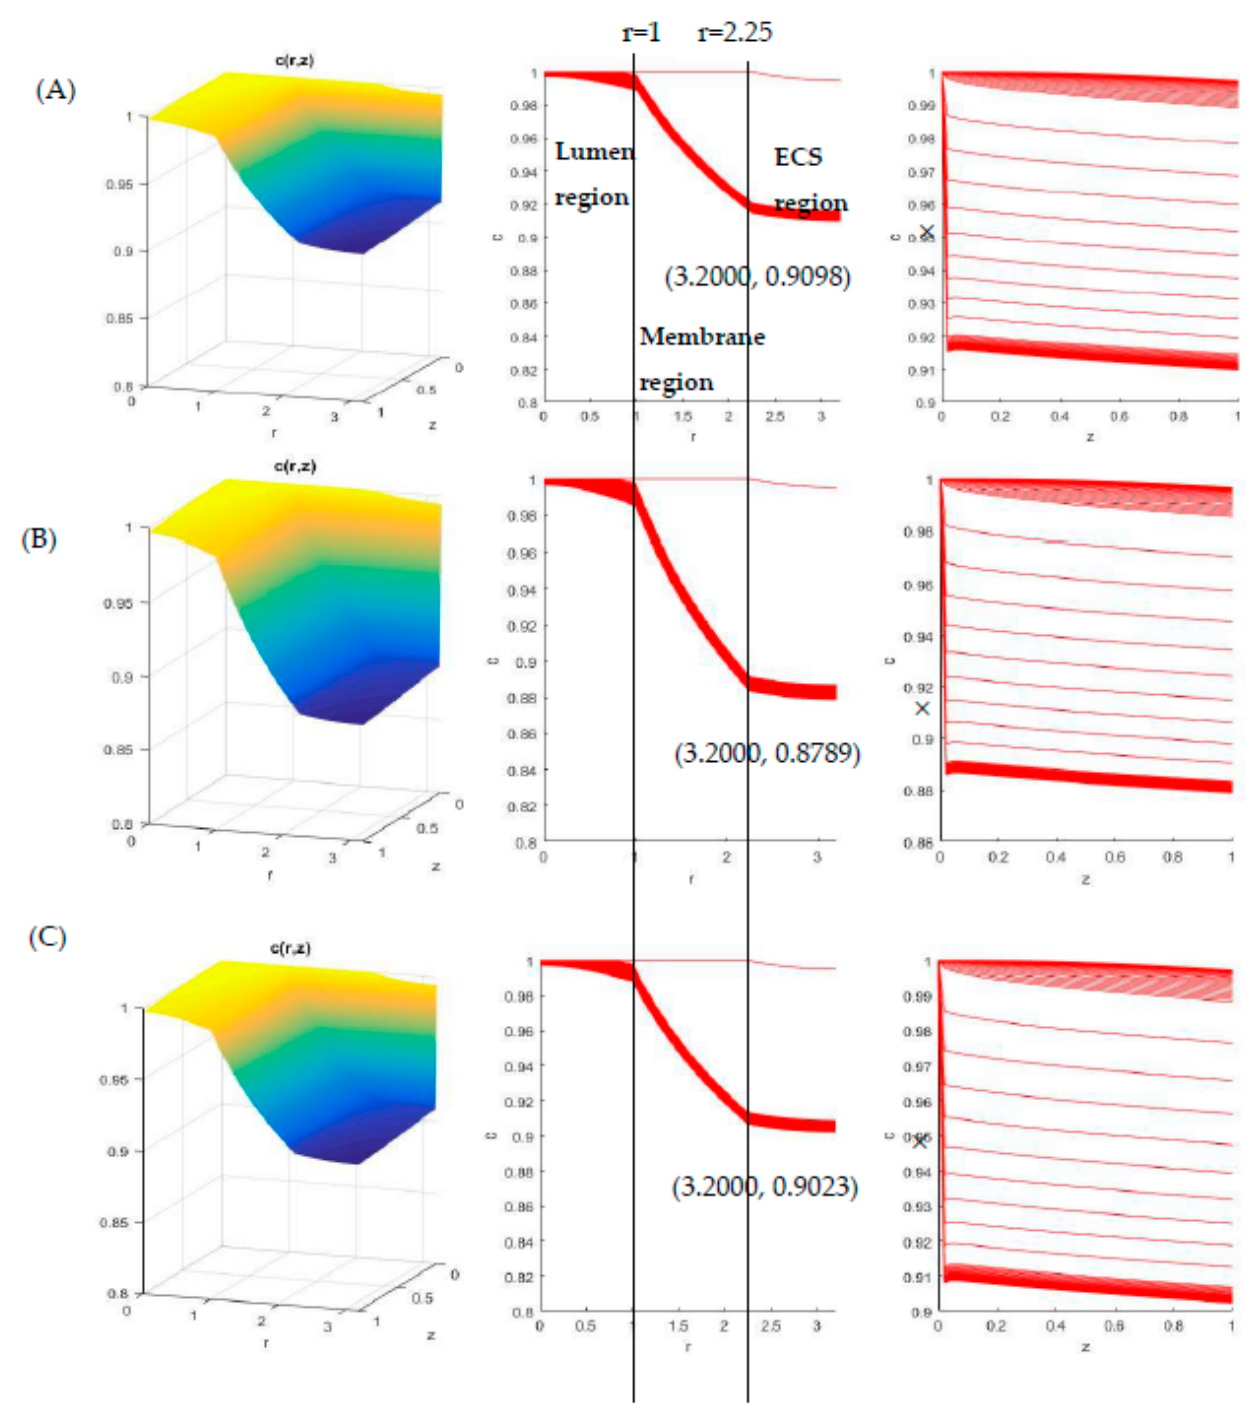
Figure 11. Glucose concentration profiles in CCM at 37 °C with ( A ) PVDF-PCL sample 1( B ) PVDF-PCL sample 2, and ( C ) PVDF-PCL sample 3.